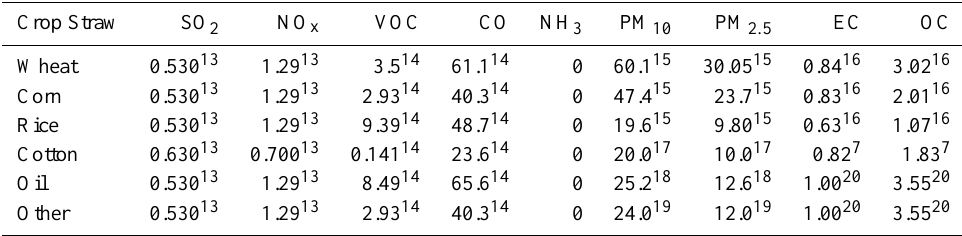
Table 8. Emission factors for crop straw burning (units: gkg − 1 ). Crop Straw SO